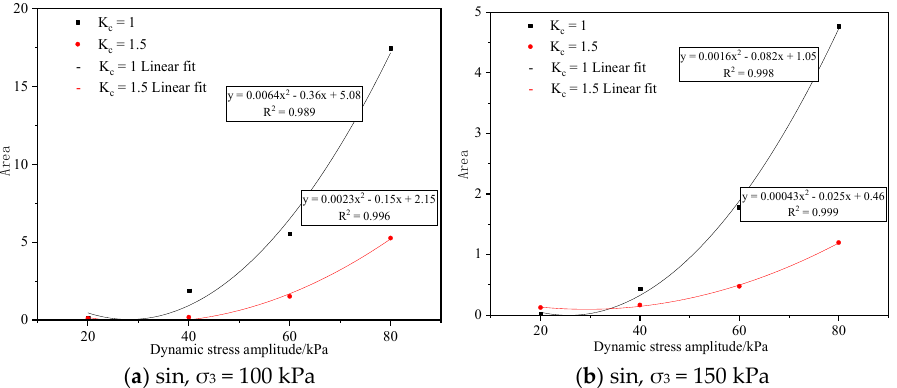
Figure 11. The second-degree parabola fitting of surrounding area of hysteretic curve under different consolidation ratio.